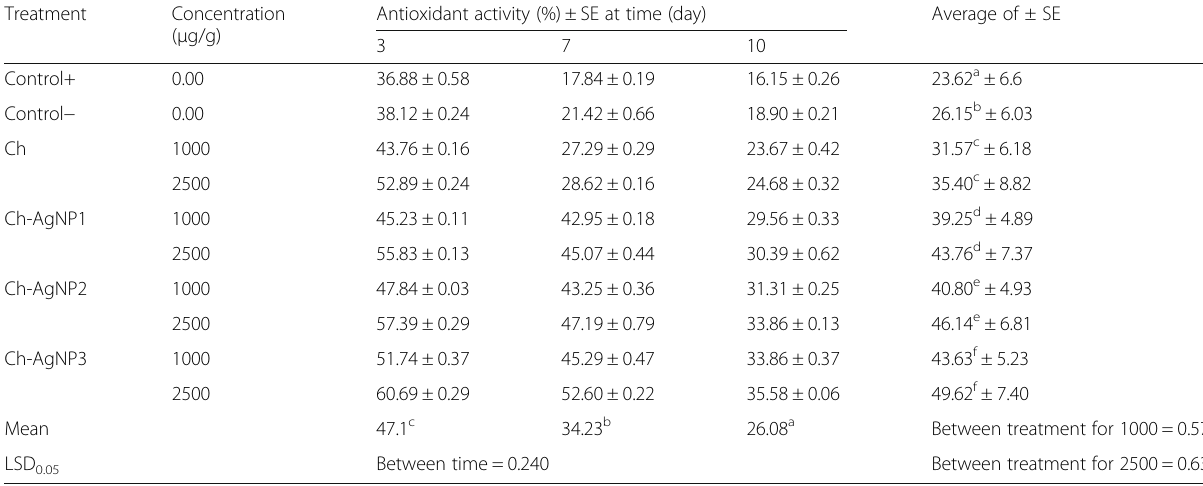
Table 5 Changes in antioxidant activity (%) in minced beef meat products treated with chitosan (Ch) and chitosan-silver nanoparticles (Ch-AgNPs) after storage for 10 days at 4 °C Treatment Concentration ( μ g/g)